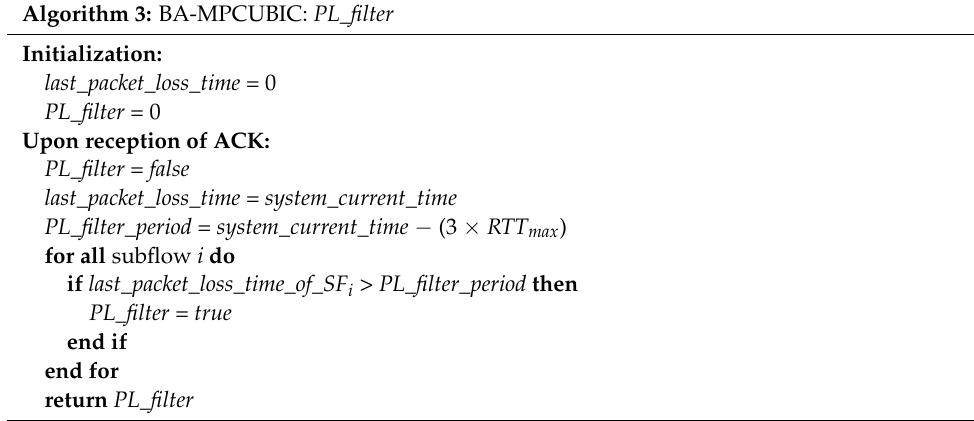
Algorithm 3: BA-MPCUBIC: